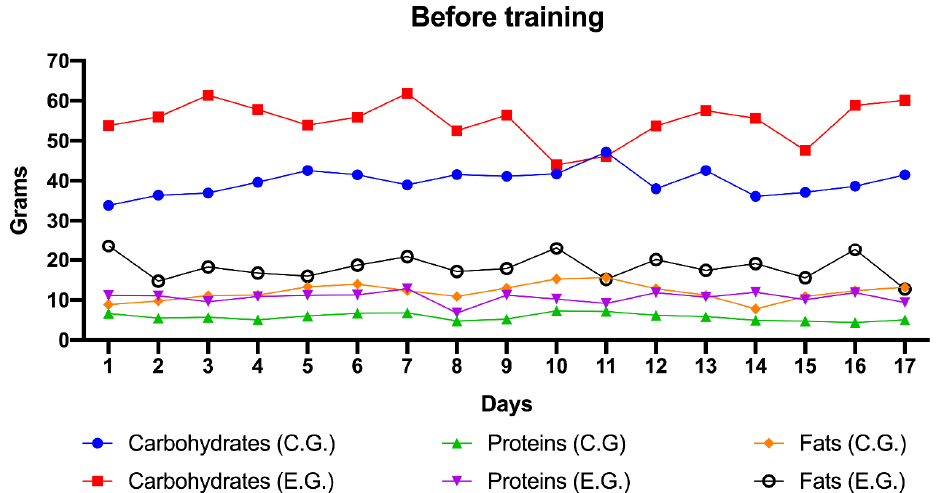
Figure 1. Values expressed in grams of carbohydrates, proteins and fats, of the control and experimental group’s snacks before training (daily data from day 1 to day 17). Note. C. G.: Control Group; E.G.: Experimental Group.